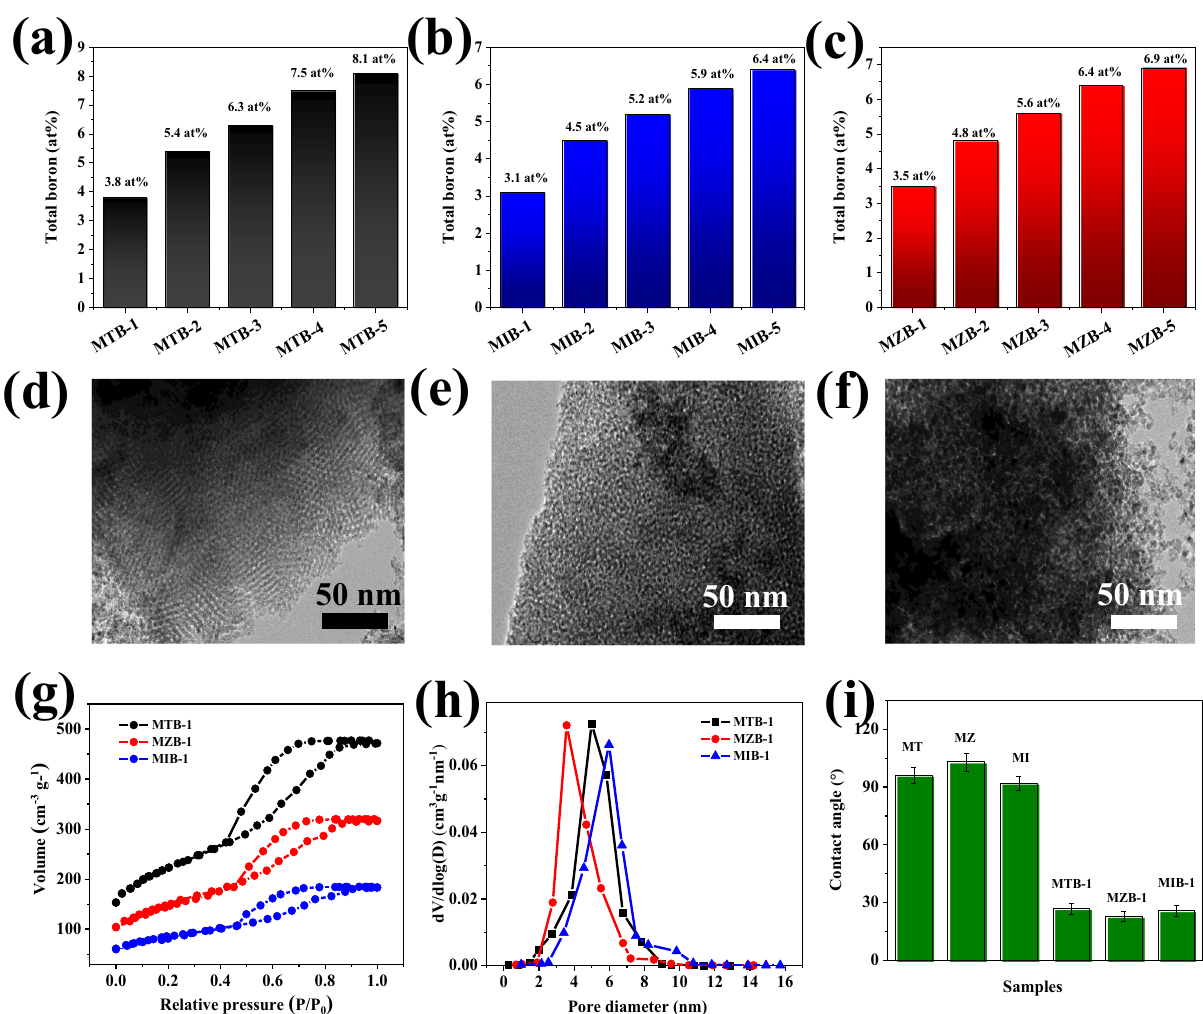
Fig. 1 Structure of boron-doped mesoporous semiconductor oxides. a – c Summary of boron-doping level in MTB, MZB, and MIB series samples. d – f High- resolution transmission electron microscopy (HR-TEM) of MTB-1 ( a ), MZB-1 ( b ), and MIB-1 ( c ). g , h N 2 adsorption − desorption isotherms and corresponding pore size distribution of mesoporous MTB-1, MZB-1, and MIB-1. i Contact angles of MTB-1, MZB-1, MIB-1 and the undoped samples (MT, MZ, and X-ray photoelectron spectroscopy (XPS; Fig. 2b – d) revealed the fol- lowing: (i) deconvoluted boron 1 s XPS shows two peaks at 192.2 and 193.1 eV, corresponding to interstitial boron and surface BO 3/2 spe- cies, respectively 17 . (ii) As the boron content increases from 3.8, 3.5,